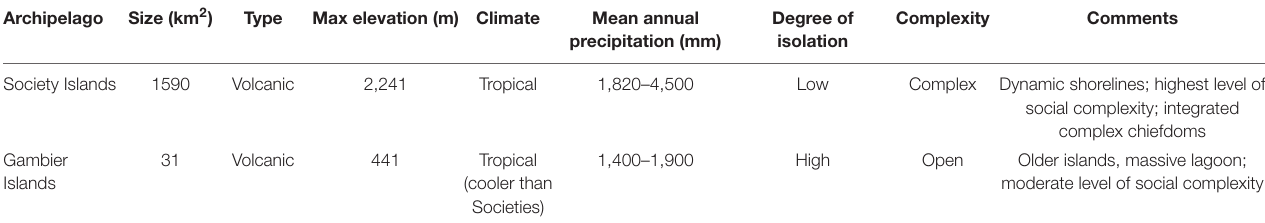
TABLE 1 | Environmental and cultural characteristics of the Society Islands and the Gambier Islands (after Conte and Kirch, 2004; Kahn, 2018, in press). Archipelago Size (km 2